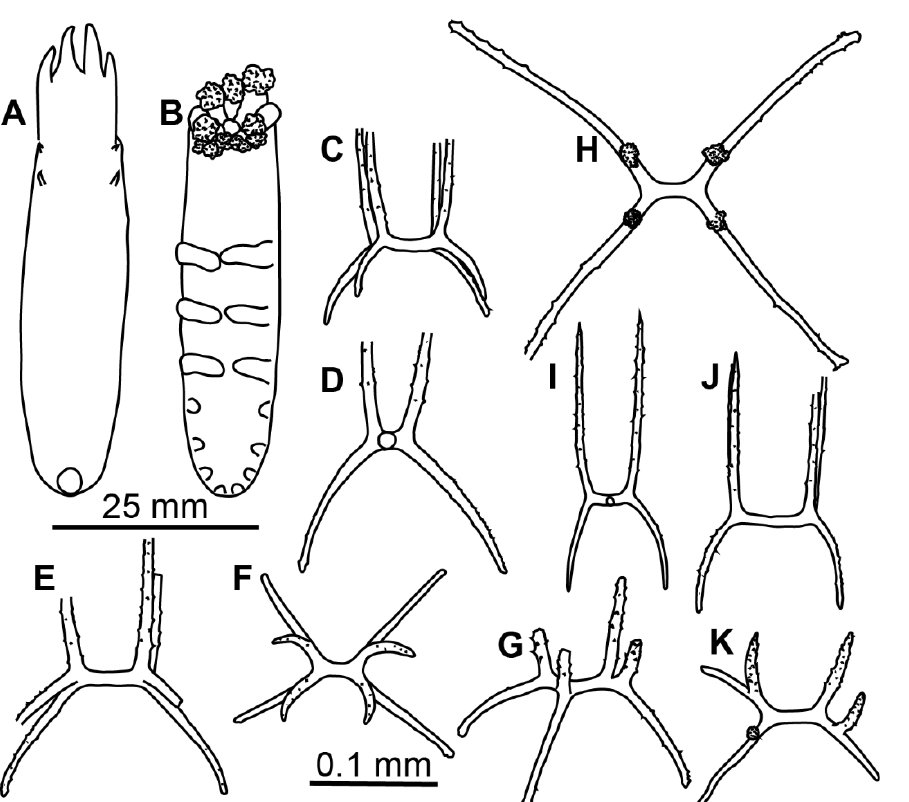
Figure 6. Peniagone saveljevae sp. nov., paratype: ( A , B ) dorsal and ventral view; ( C – G ), dorsal ossicles; ( I – K ) ventral ossicles.